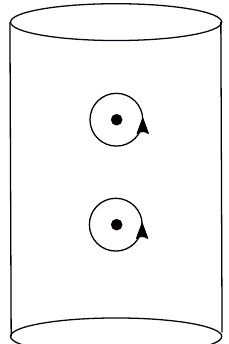
Figure 1 . The cylinder with twist insertions at w 1 and w 2 and supercharge contours circling the twist